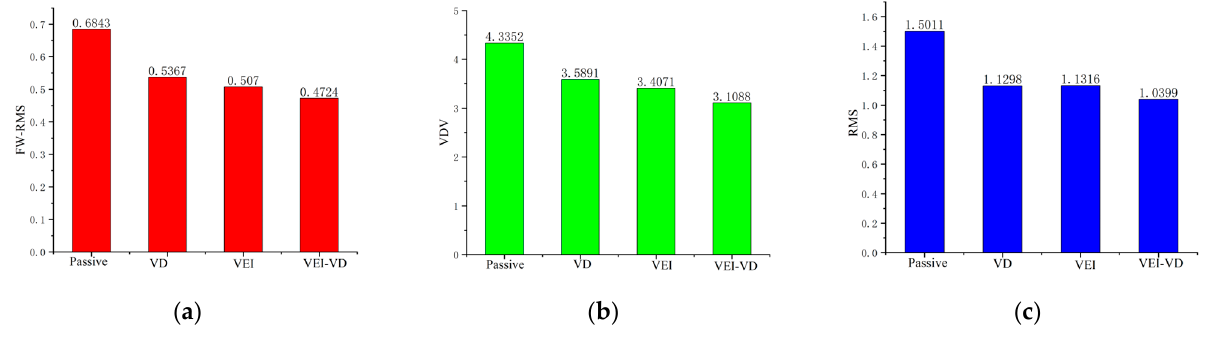
Figure 18. Acceleration in the frequency domain: ( a ) Entire experiment; ( b ) Zoom in.